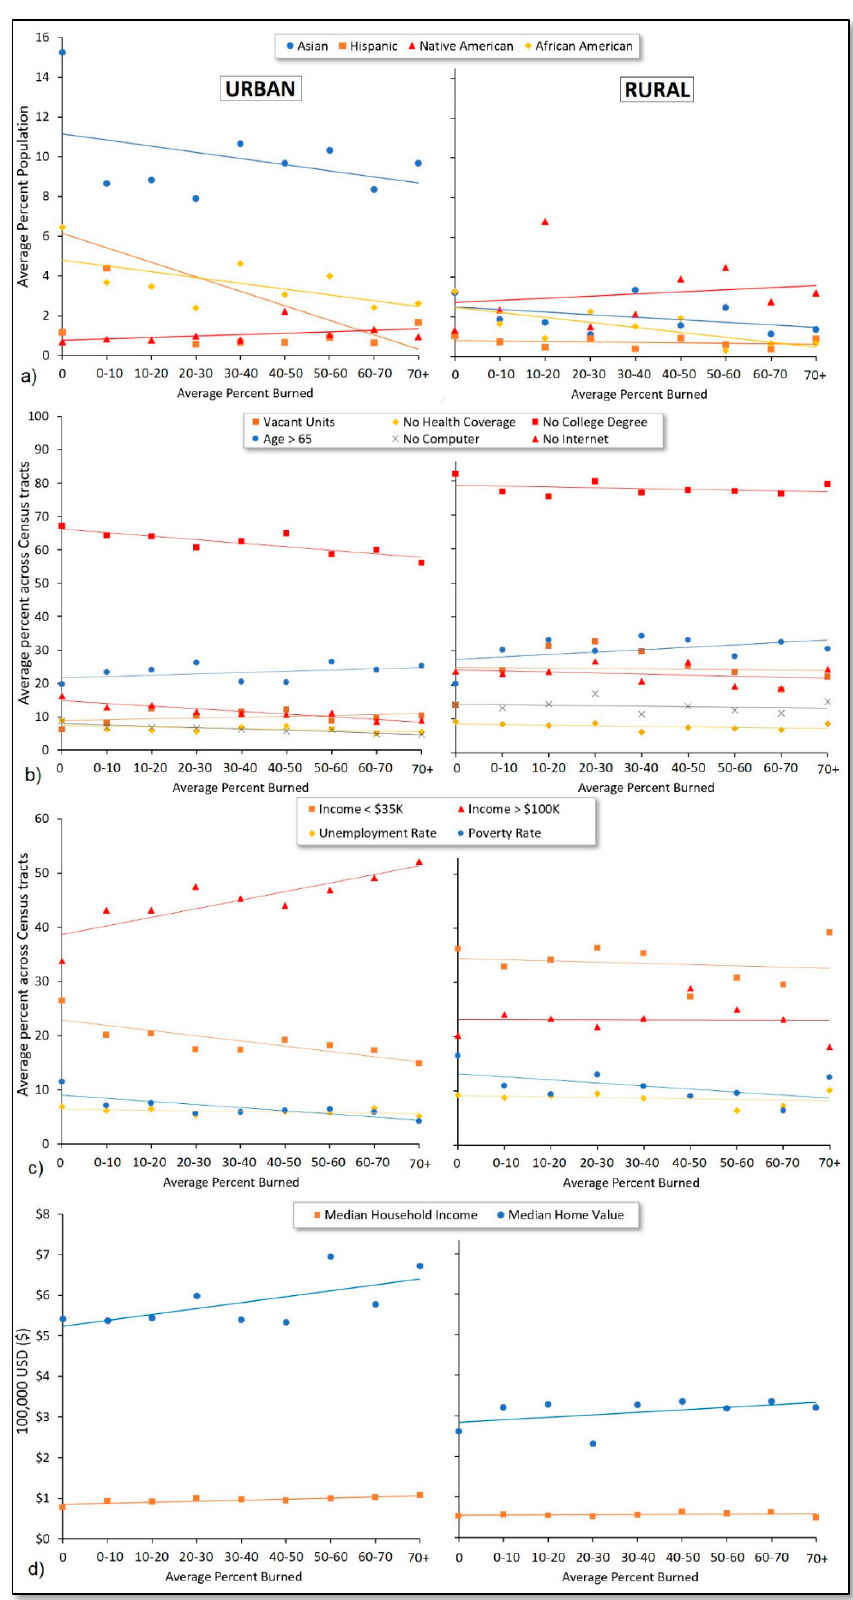
Figure 5. Percentage of ( a ) minority populations, ( b ) wildfire vulnerability indicators, and ( c , d ) economic indicators averaged across Census tracts grouped by the percent of cumulative Census tract land area burned from 2000–2020.